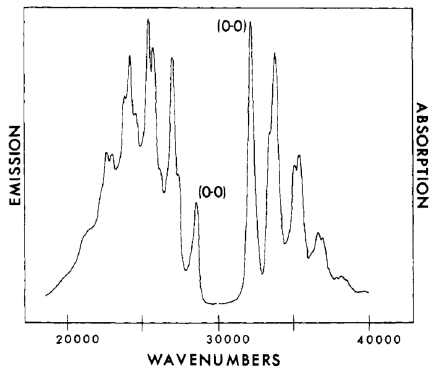
Figure 6. Fluorescence and absorption spectra of all trans ‐ 1,3,5,7 ‐ octatetraene in 3 ‐ methylpentane at 77K. Left, fluorescence on an arbitrary emission scale; right, absorption on an arbitrary absorbance scale [58].